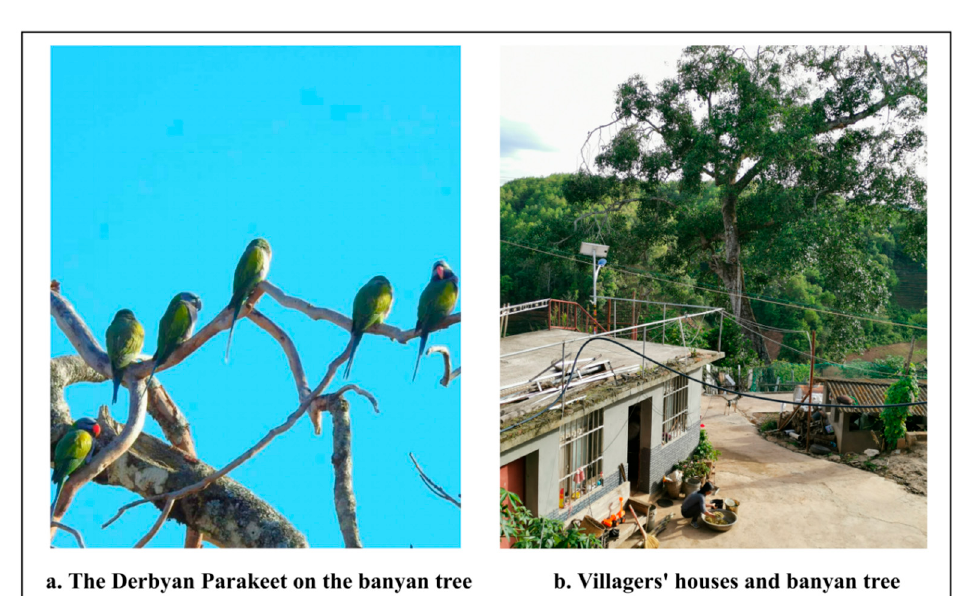
Figure 3. Parrots perched on banyan trees in the village.